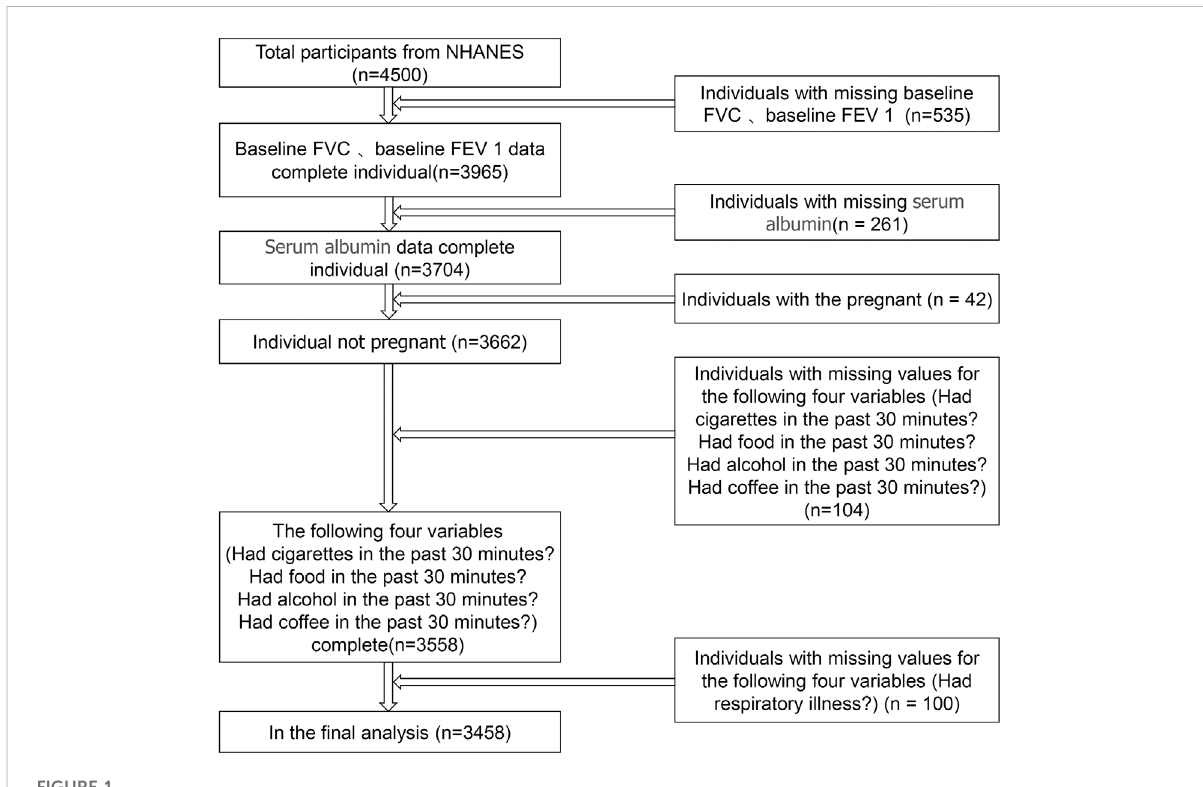
FIGURE 1 Participants ’ screening fl